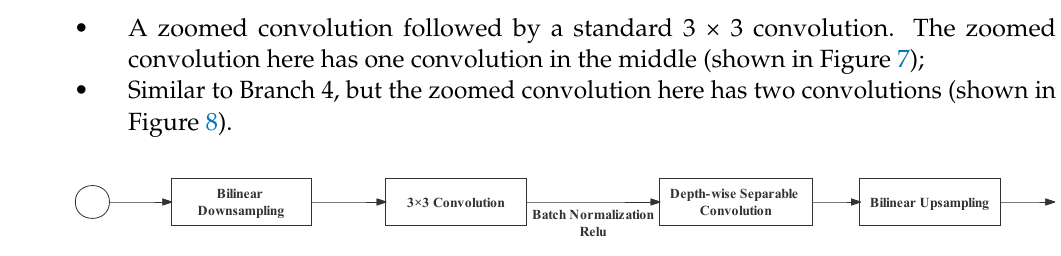
Figure 6. Zoomed convolution with two convolutions in the middle.